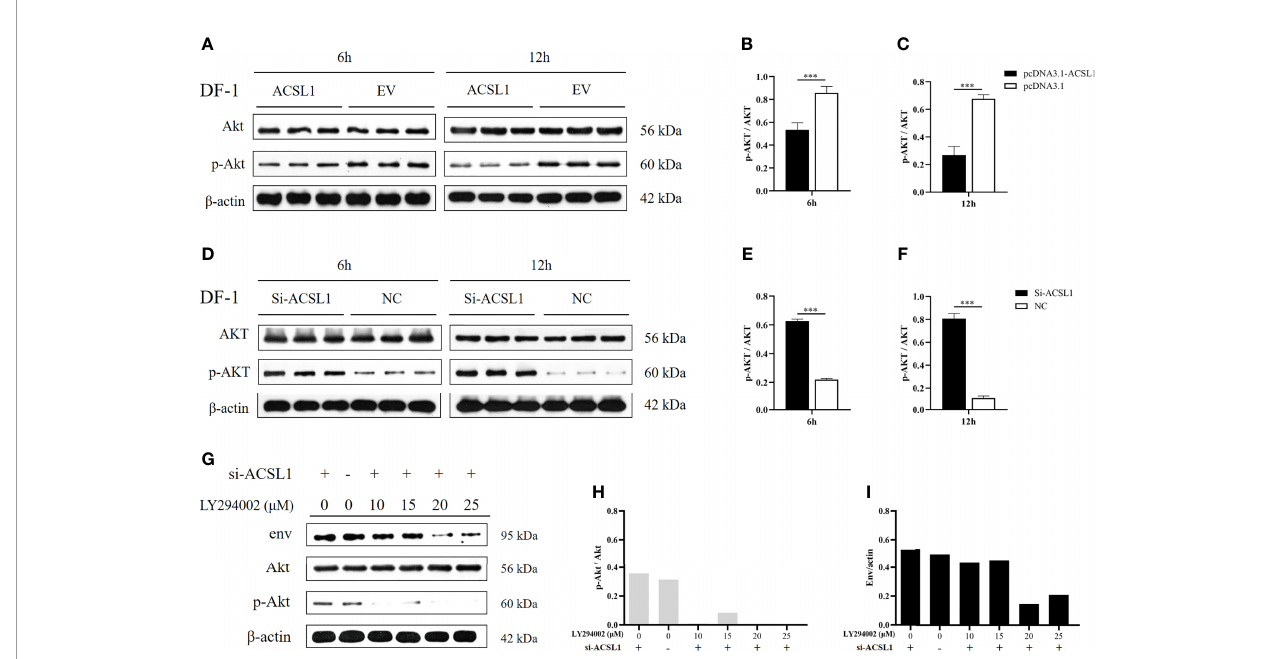
FIGURE 3 | ACSL1 inhibited the activation of Akt. (A – C) Immunoblot analysis of Akt and p-Akt expression from ACSL1 overexpression cells for the indicated time (A) . Statistical analysis of the relative abundance of protein between p-Akt and Akt (B, C) . (D – F) Immunoblot analysis of Akt and p-Akt expression from ACSL1 knockdown cells for the indicated time (D) . Statistical analysis of the relative abundance of protein between p-Akt and Akt (E, F) . (G – I) LY294002 were pretreated in ACSL1 knockdown cells for 1h and then infected with ALV-J. Immunoblot analysis of env, Akt, and p-Akt expression for the 12 h (G) . S tatistical analysis of the relative abundance of protein between p-Akt and Akt (H) , env and actin (I) . The experiments were repeated three times, independently, with similar results obtained. Data shown are the means±SEM (n=3). P values were calculated using two-tailed unpaired Student ’ t-test. Differences with P<0.05 were considered signi fi cant. ***P <